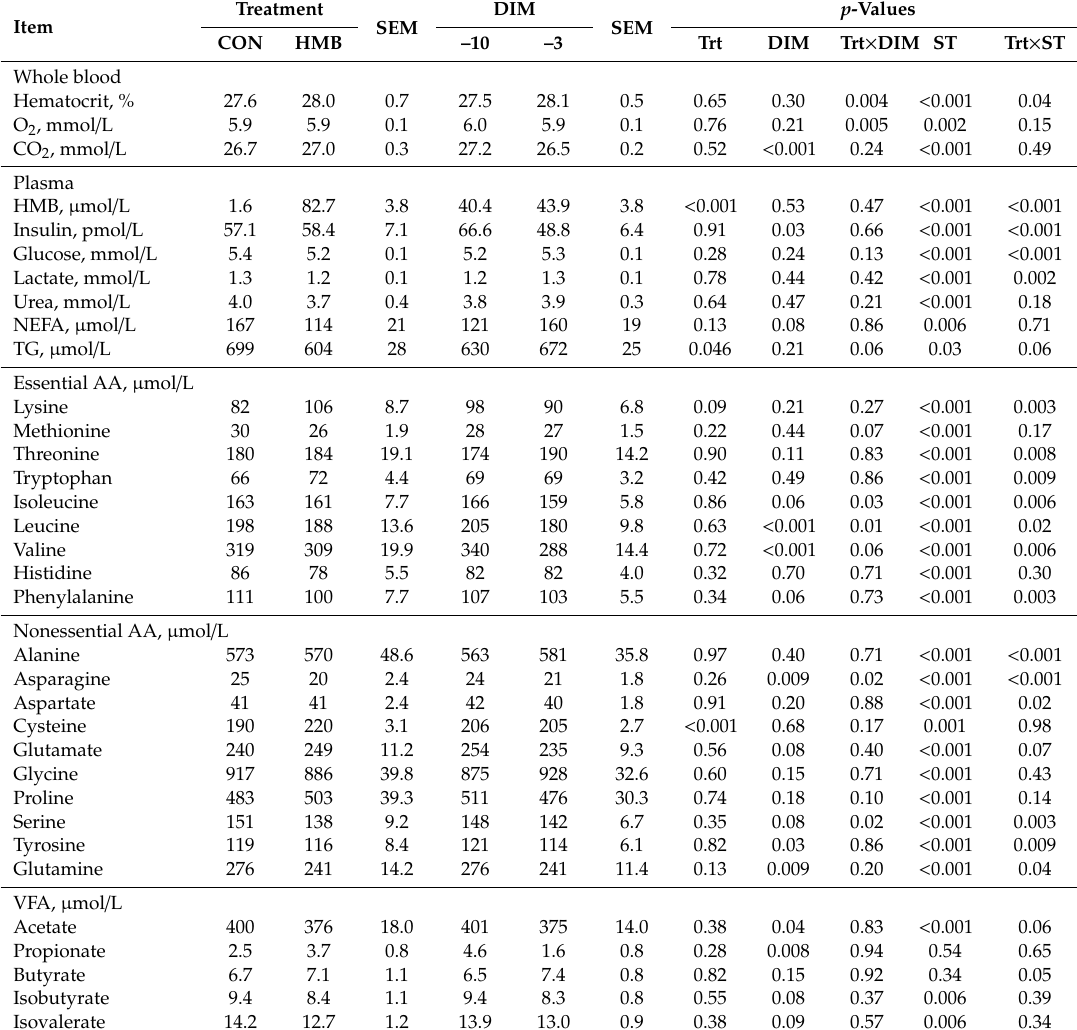
Table 3. The arterial concentration of blood gases, hematocrit, and plasma metabolites of control (CON) and HMB-supplemented (HMB) sows during late